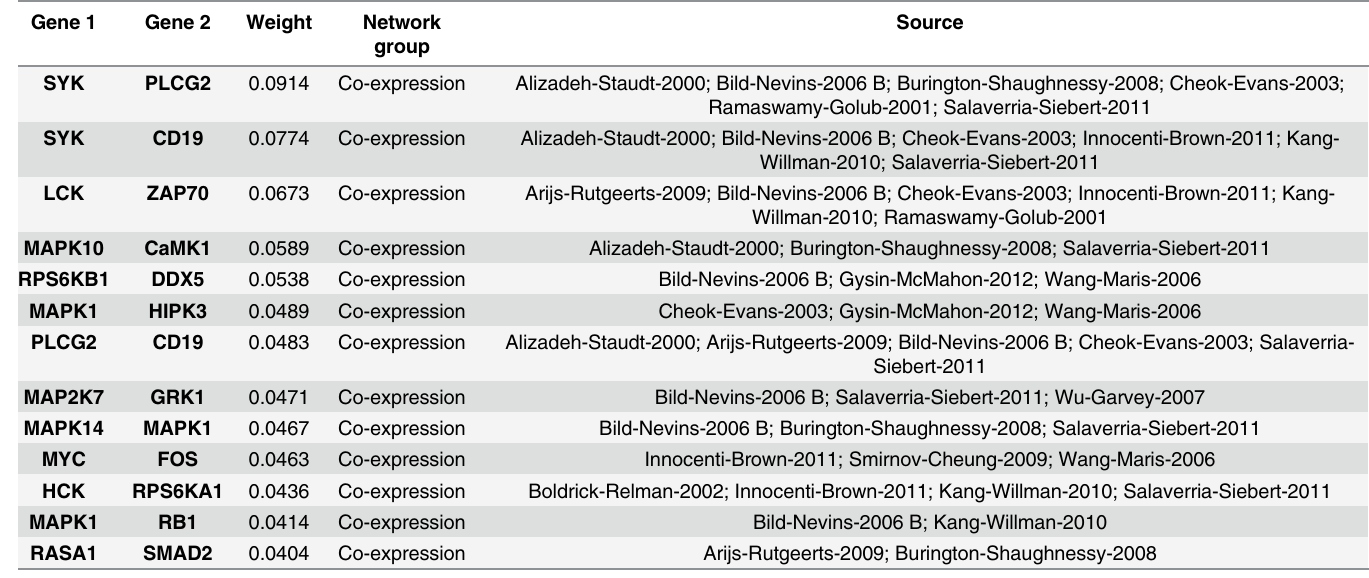
Table 8. List of co-expressed phosphoproteomes with differential expression and sources of information on gene expression patterns using the GeneMANIA tool. (Weight (cid:1) 0.04). Gene 1 Gene